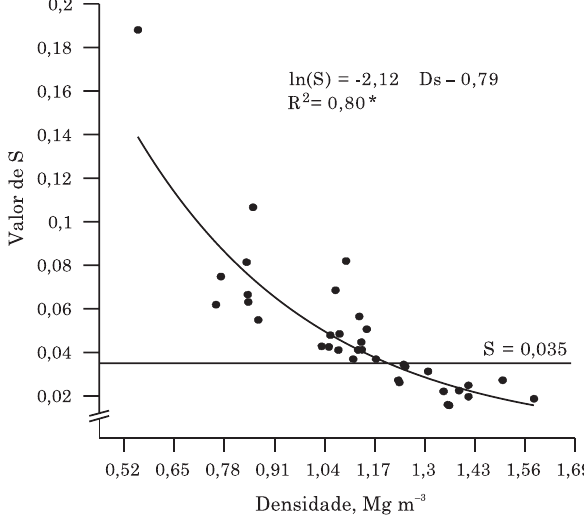
Figura 4. Comportamento do parâmetro S em função da densidade do solo. (*: o modelo ajustado é significativo a p < 0,01 pelo teste